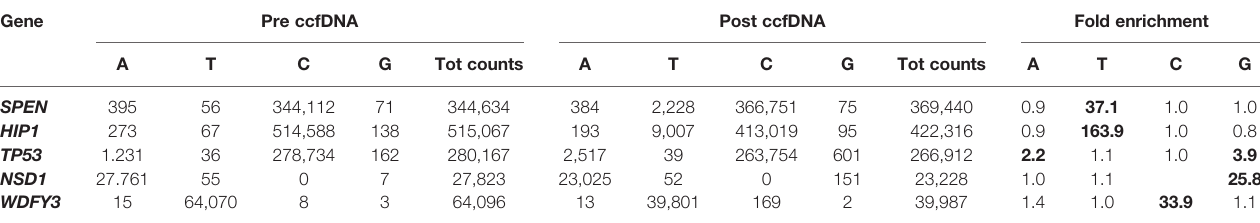
TABLE 2 | Enrichment in ctDNA post